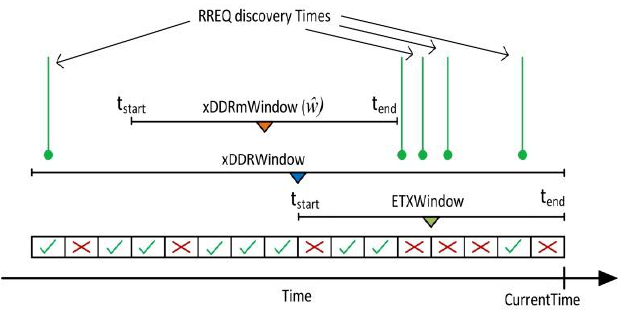
Figure 4: xDDR measurement window w.r.t